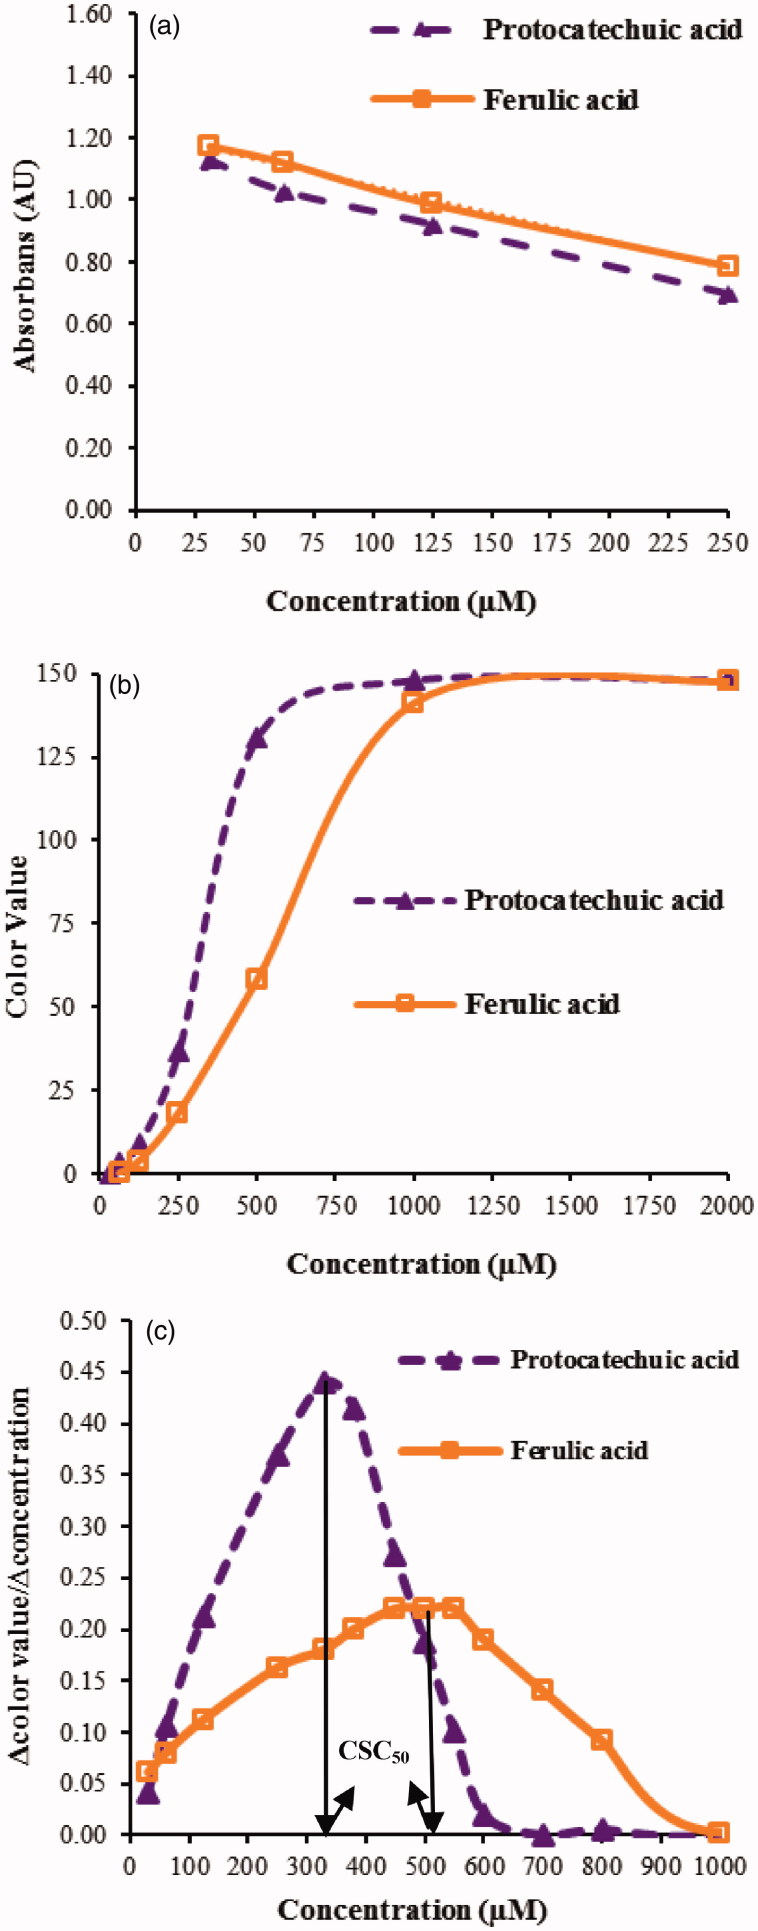
(a) Concentration–absorbance graph used to calculate SC50, (b) concentration–colour value graph used to calculate CSC50 and (c) 1st degree derivative graph used to calculate CSC50 for protocatechuic acid and ferulic acid standards.